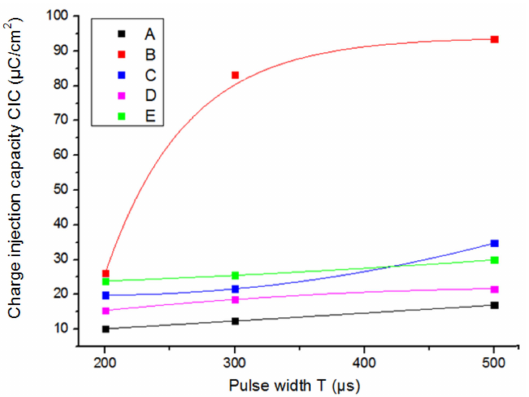
Figure 5. Maximum reversible charge injection capacity (CIC) as a function of the pulse width of the stimulation signal.